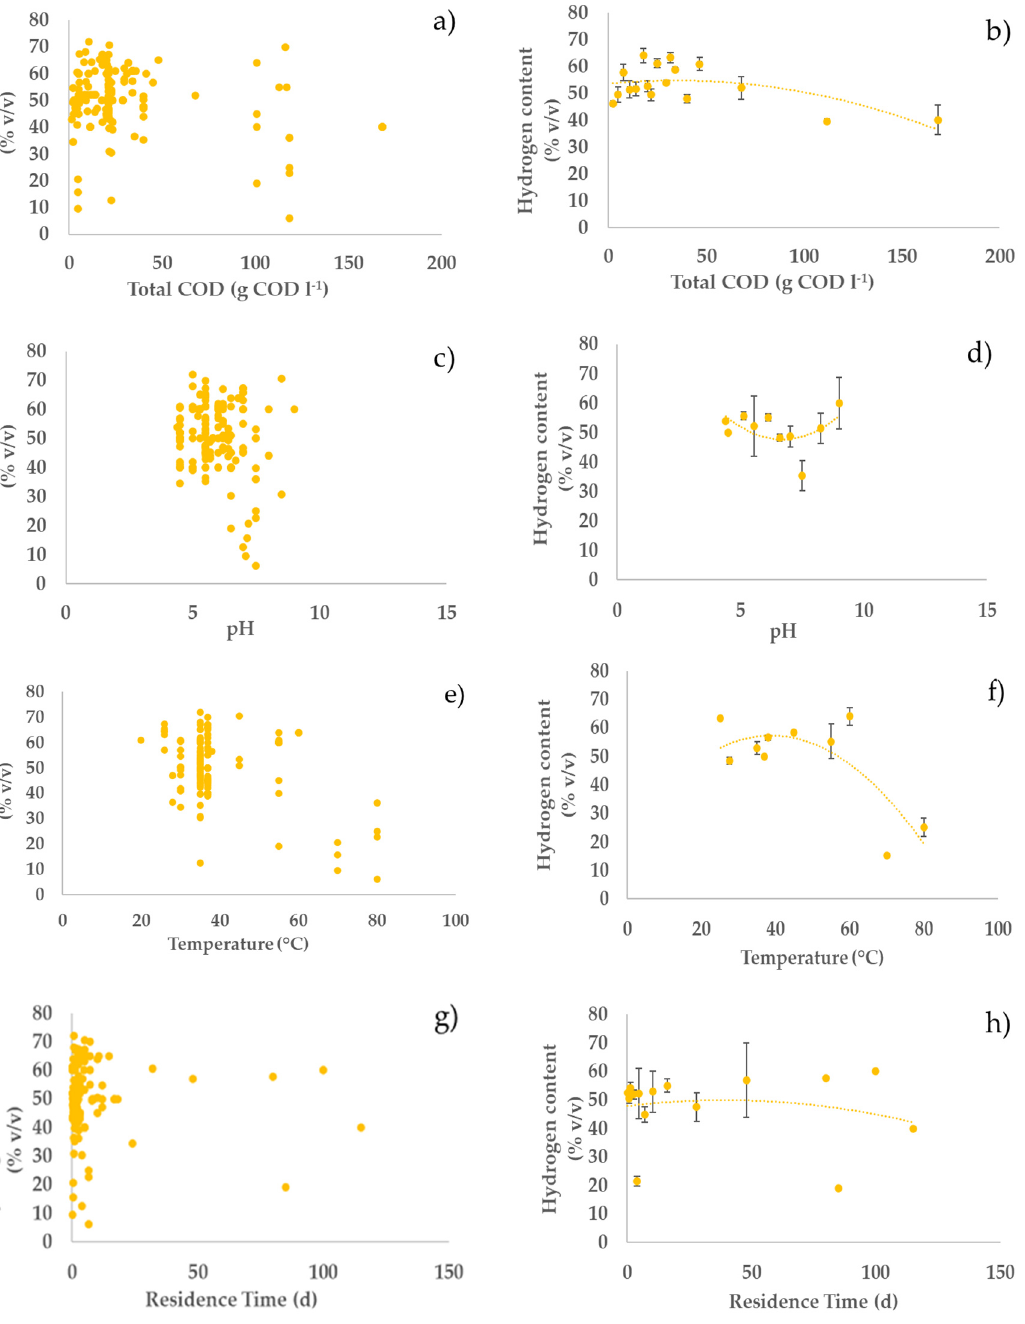
Figure 2. Relationships between hydrogen productivity and operational parameters: ( a , c , e , g ) all considered experiments; ( b , d , f , h ) average values of experiments in each narrow range (width max- imum 20%) of the operating parameters (error bars indicate the standard error) with second-order polynomial curve. The polynomial curve is only used to visualise the general trend, without any statistical significance.